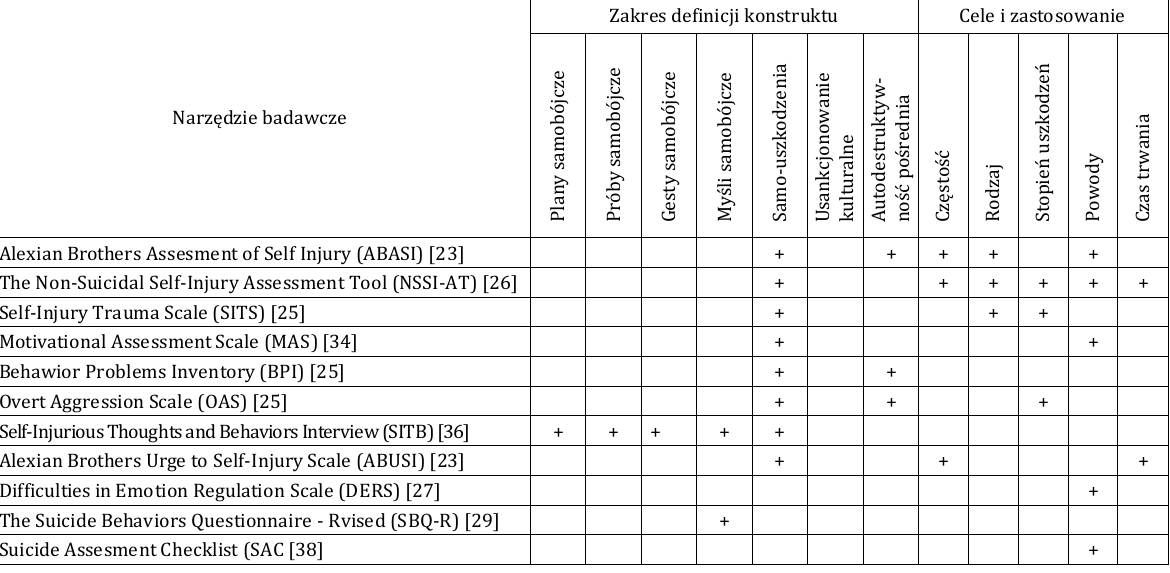
tab. 1 autorstwa Kubiak [51] oraz tab. 2 przygotowanej przez autorów tego artykułu (zawierającą skale nie uwzględnione w tab.1).